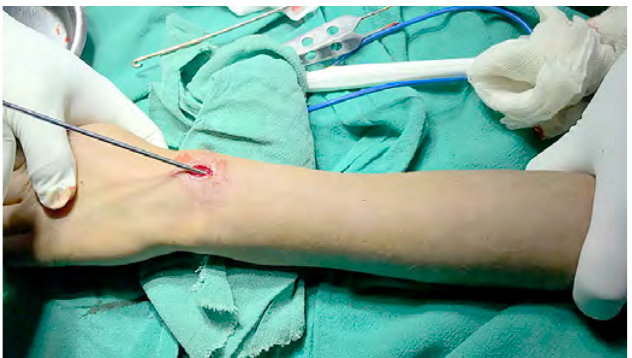
Fig 4 : Retrograde rush pin insertion for